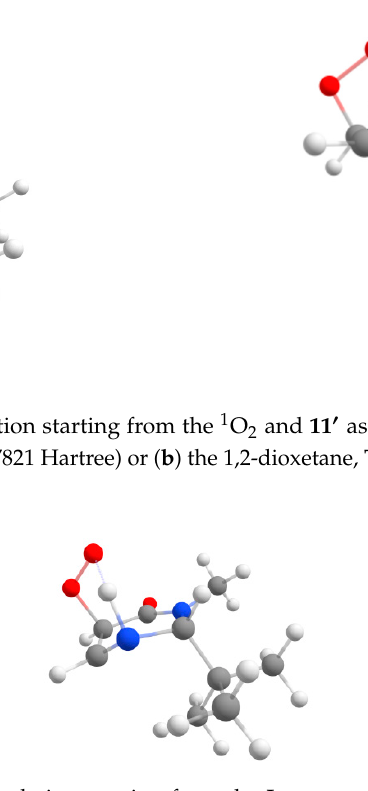
Figure 10 . TS2 Z from QST2 calculation starting from the I Z as reactant and the hydroperoxide as product P (E = –687.571828 Hartree).